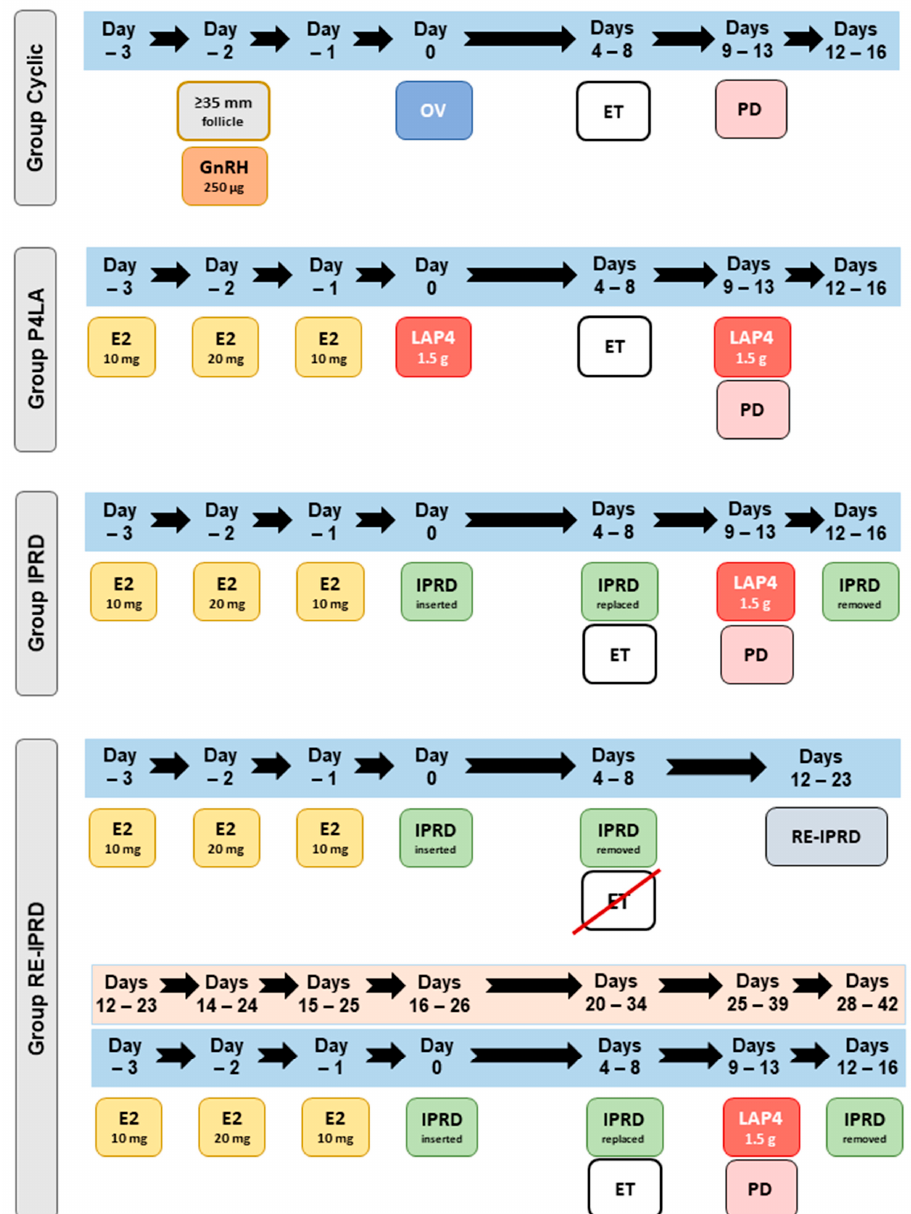
Figure 3. Timeline for hormone treatments administered to synchronize and resynchronize embryo recipient mares for embryo transfer. Cyclic: cyclic mares having ovulation confirmed after induction of ovulation (follicle ≥ 35 mm) with histrelin acetate (250 µ g); LAP4: acyclic mares treated with estradiol-17 β for 3 days (E2-3d) and then administered a single dose of long-action progesterone (LAP4, 1.5 g); IPRD: acyclic mares treated with E2-3d and then given an IPRD containing 1 g of natural progesterone; RE-IPRD: acyclic mares synchronized as in the IPRD group but not used for embryo transfer, then 8 to 15 days later (i.e., D12–D23 after the first synchronization), the mares were resynchronized with E2-3d and IPRD for 4–8 days. Embryo transfers (ET) were performed between 4 and 8 days after ovulation or progesterone treatment. Pregnancy diagnosis (PD) was performed five days after ET (Days 9–13). Pregnant embryo recipient mares from groups LAP4, IPRD, and RE-IPRD received weekly injections of LAP4 at PD. Pregnant mares in Groups IPRD and RE-IPRD had the device removed three days after the first